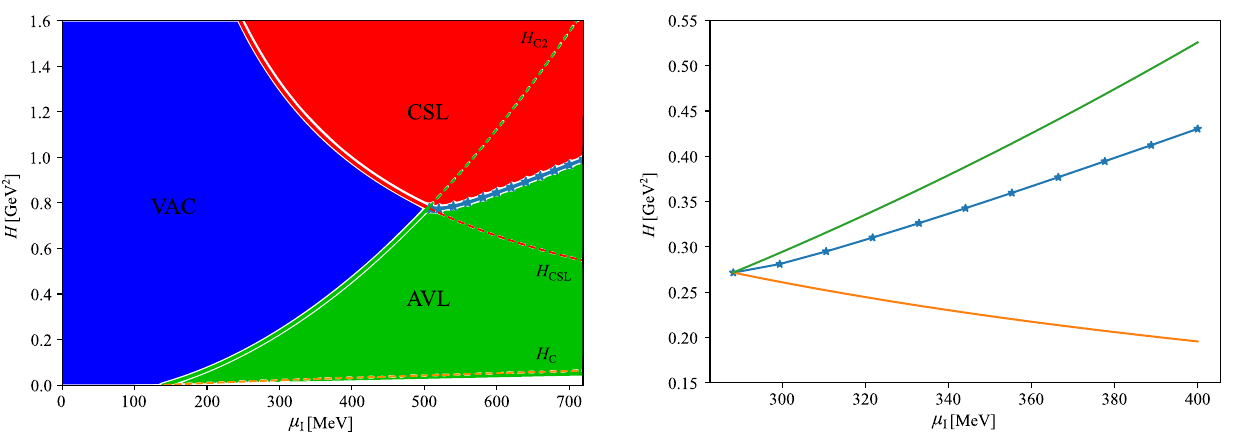
Fig. 4 Phase diagram of iQCD as a function of external magnetic field and isospin chemical potential for the physical pion mass, m π = 140 MeV. The thick solid lines indicate phase transitions between the vacuum (VAC), Abrikosov vortex lattice (AVL) and CSL phases. For orientation, we also show the upper critical field H c2 which defines the transitionbetweentheVACandAVLphases,andthecurve H CSL ,defin- ing the transition between the VAC and CSL phases. The lower critical field H c1 separating the AVL phase from the uniform BEC phase was not possible to determine accurately due to convergence issues. The phase transition between the BEC and AVL phases however lies below H c , indicated by the thin dashed line near the horizontal axis